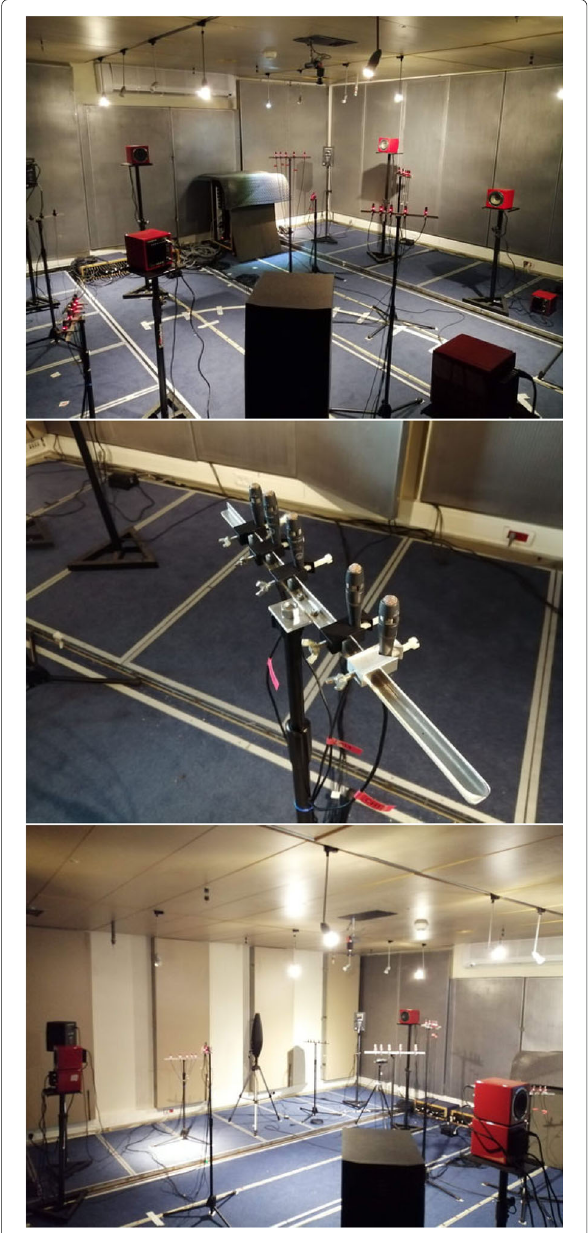
Fig. 2 Pictures of the acoustic lab. From left to right: the overall setup, one microphone array, and the setup with revolved panels